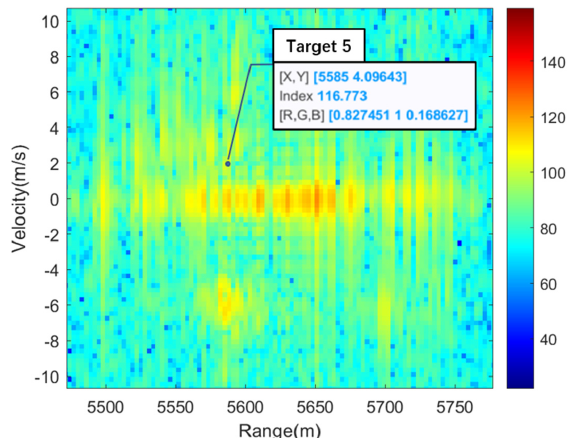
Figure 12. The st − MIMO − ICA result of Target 4: ( a ) velocity spectrum at Target 4 (cid:48) s range bin before st − MIMO − ICA processing, where the target was submerged in strong ground clutter; ( b ) velocity spectrum comparison.